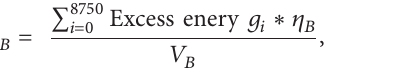
The battery size ( 𝐸 𝐵 ) is estimated using the excess energy, and it is expressed as